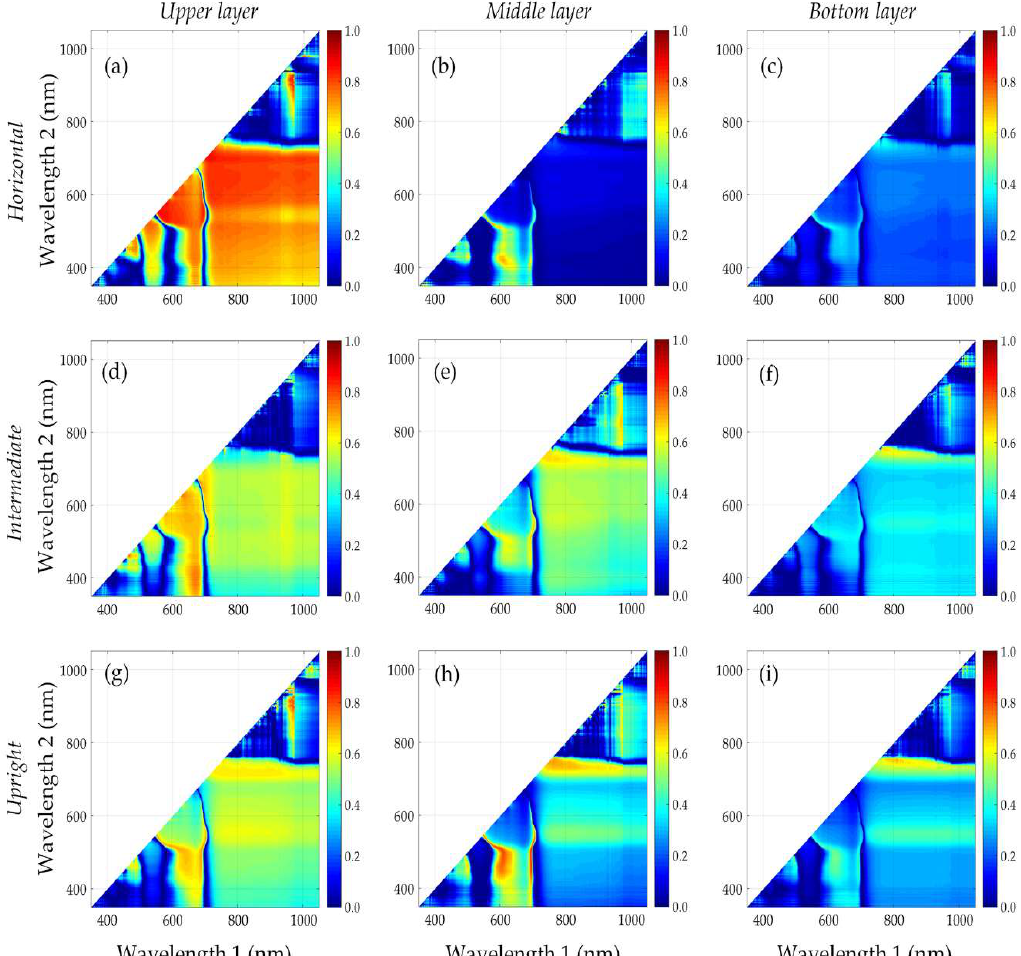
Figure 3. Maps showing the R 2 for the relationships between the leaf N density and SR index calculated from all possible 2-band combinations in the range of 350–1050 nm during the V6 to V12 stages. ( a ) The upper layer of the horizontal leaf varieties, ( b ) the middle layer of the horizontal leaf varieties, ( c ) the bottom layer of the horizontal leaf varieties, ( d ) the upper layer of the intermediate leaf varieties, ( e ) the middle layer of the intermediate leaf varieties, ( f ) the bottom layer of the intermediate leaf varieties, ( g ) the upper layer of the upright leaf varieties, ( h ) the middle layer of the upright leaf varieties, and ( i ) the bottom layer of the upright leaf varieties.